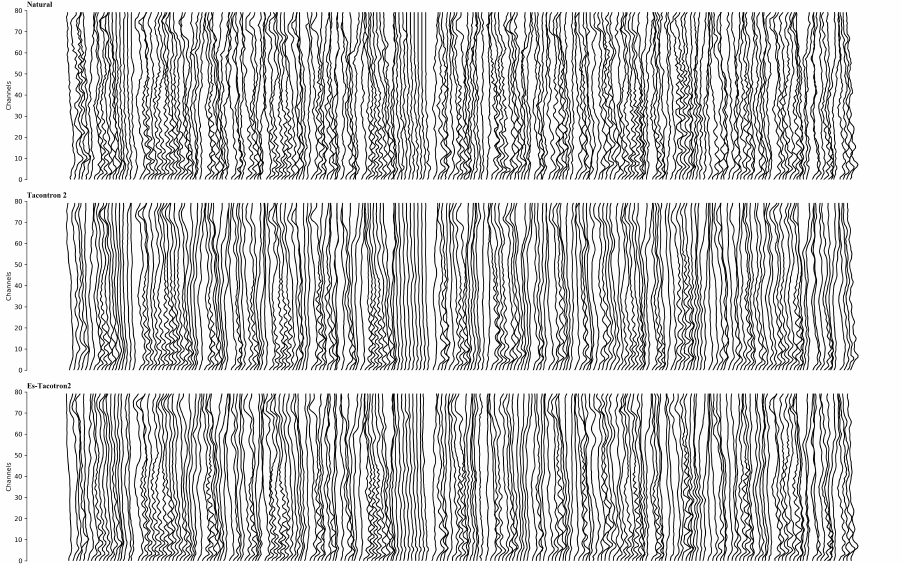
Figure 5. The spectrum sequence of synthesized spectrogram by original Tacotron 2, synthesized spectrogram by Es-Tacotron2 and natural spectrogram with teacher-forcing mode. Please note that all spectrum sequences samples synthesized spectrogram at 1